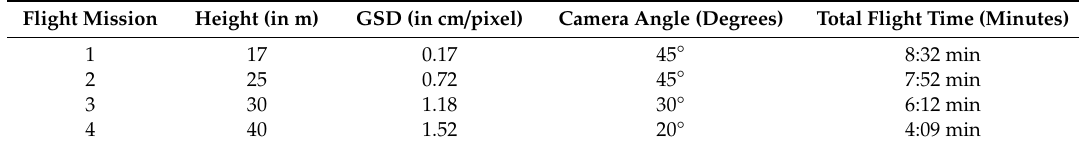
Table 3. Scenario 1 flight mission parameters.